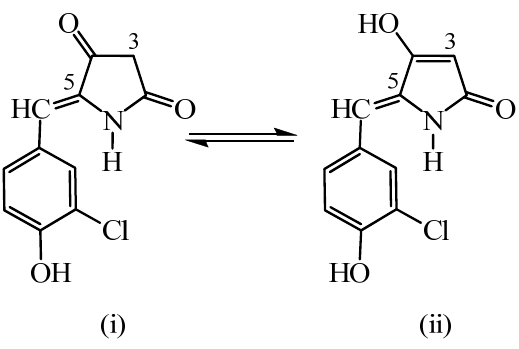
Figure 2. Z-configuration of the exocyclic double bond.